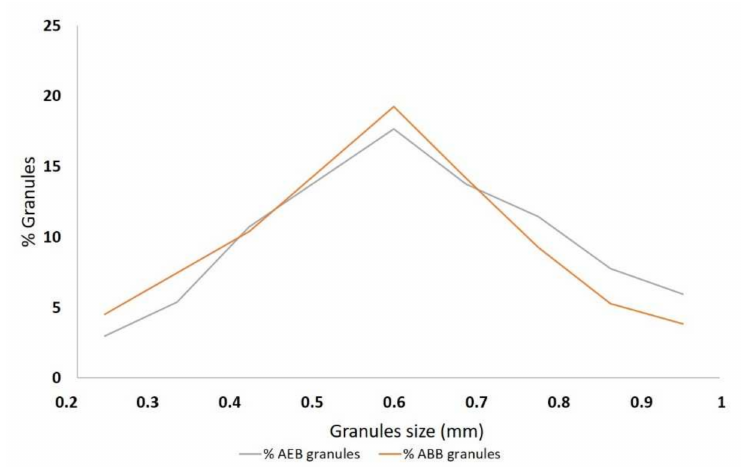
Figure 3. Graphical representation of the granule size distribution of AEB and ABB measured with SEM. On the x -axis the granules size in shown in millimeters, whereas on y -axis is shown the percentage of granules for each